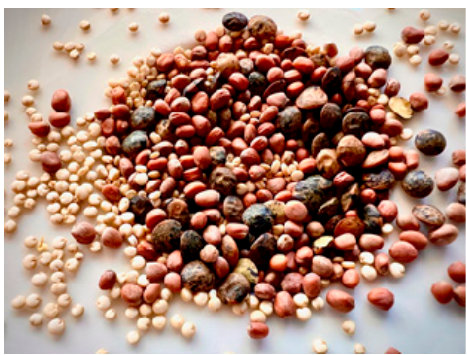
Figure 1. Dormant seed with stored reserves. A display of a seed mix for sprouting, consisting of quinoa ( Chenopodium quinoa ), lentil ( Lens culinaris ), and radish ( Raphanus sativus ) seed.